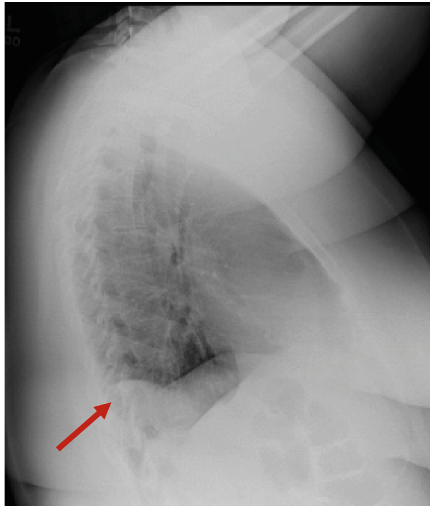
Figure 2: Lateral chest radiograph showing a mass density in the right posterior costophrenic angle with diaphragmatic contour irregularity representing the right side of the bilateral Bochdalek